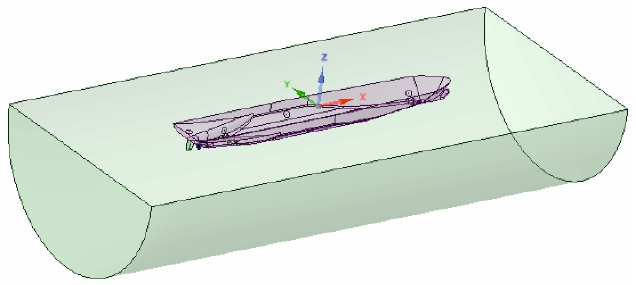
Figure 7. The semi-cylindrical artificial boundary, where the zero current density boundary condition is imposed.